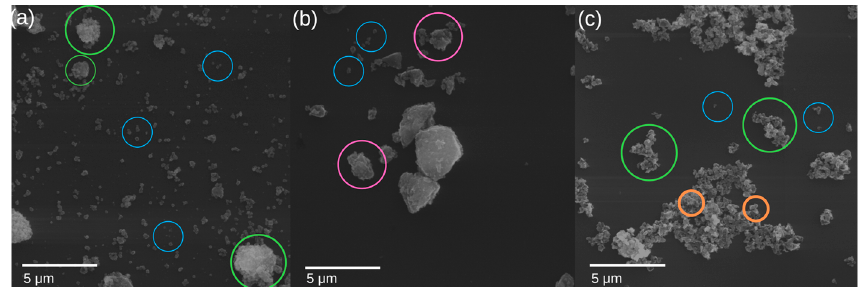
Figure 11. SEM images of iron pigments (SEM HV: 30 kV; SEM MAG: 30 kx): ( a ) CZ 14%, ( b ) CZ 28%, ( c ) Commercial pigment A.